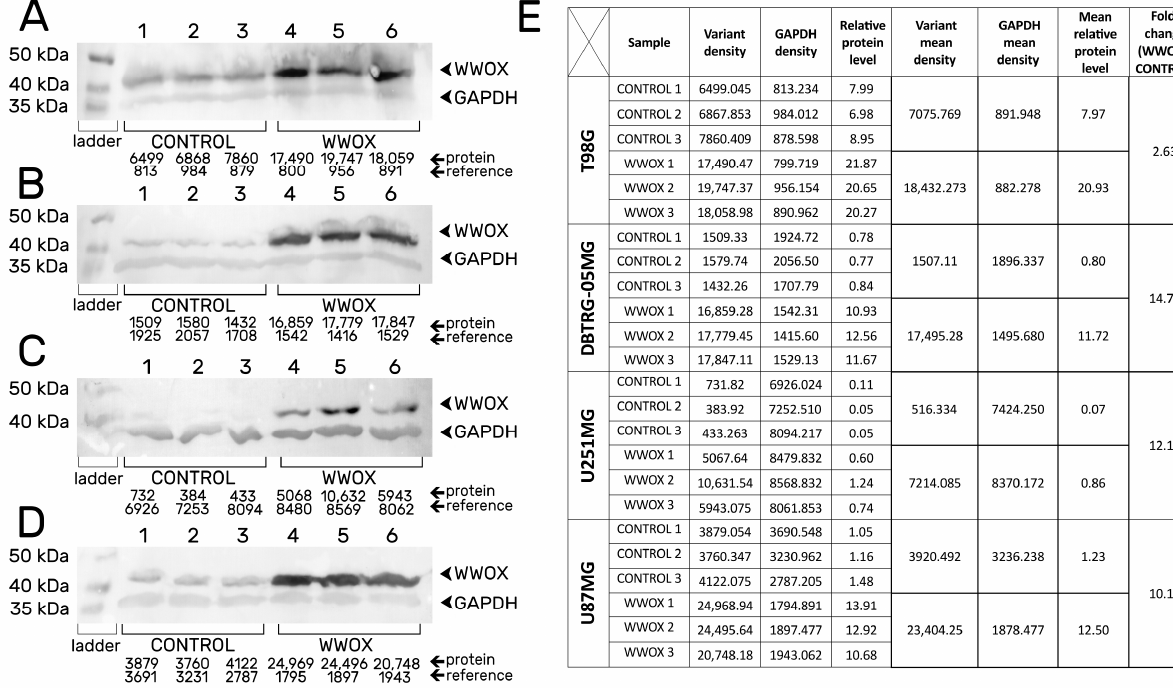
Figure 1. Stable transduction confirmation on the protein level for ( A ) T98G, ( B ) DBTRG-05MG, ( C ) U251MG, and ( D ) U87MG cell lines. ( E ) The tabular form of densitometric values.